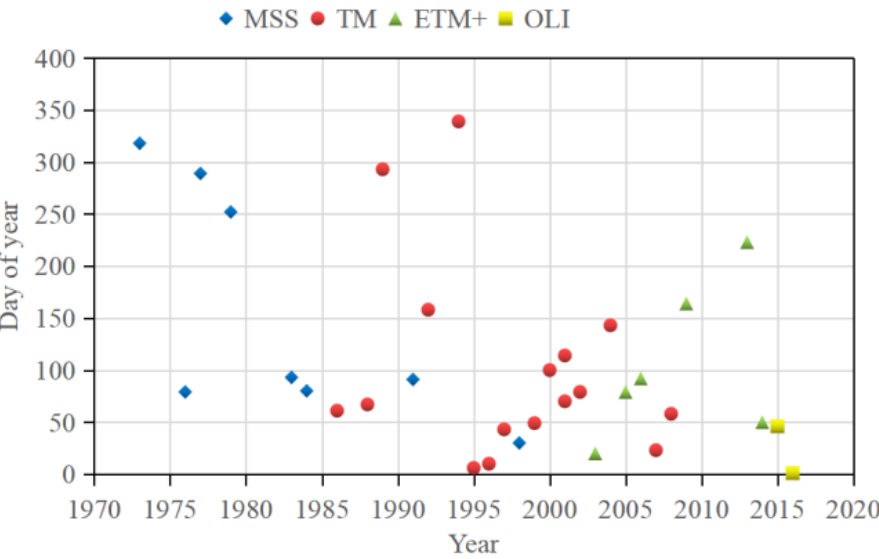
Figure 2. Date of acquisition of satellite imagery used in this study. (Landsat multispectral scanner (MSS); Thematic Mapper (TM); Enhanced Thematic Mapper (ETM+) and Operational Land Imager (OLI)).